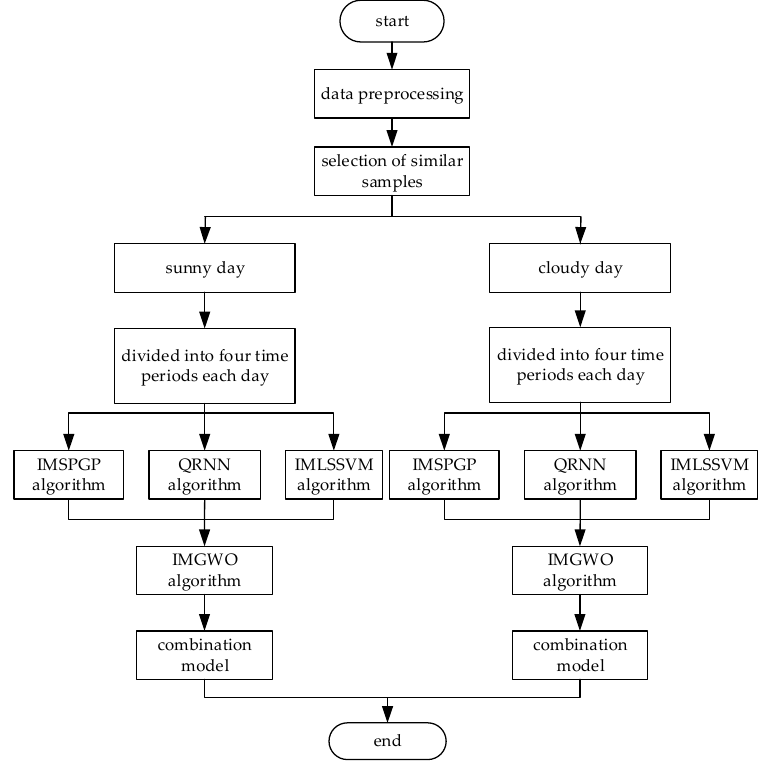
Figure 2. The flow chart of combination algorithm.